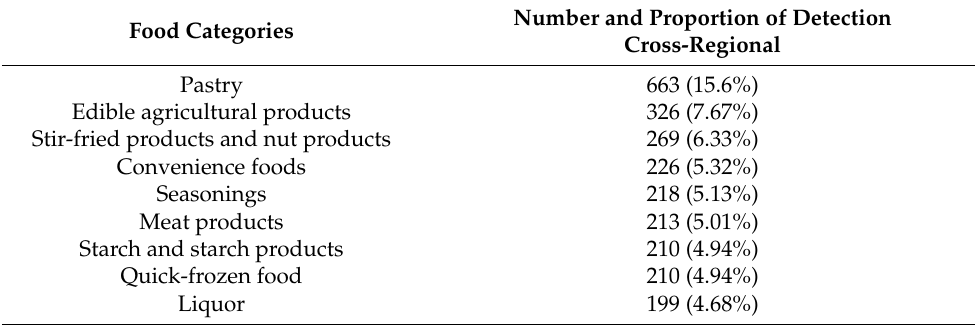
Table 3. The proportion of cross-regional transferred unqualified products.